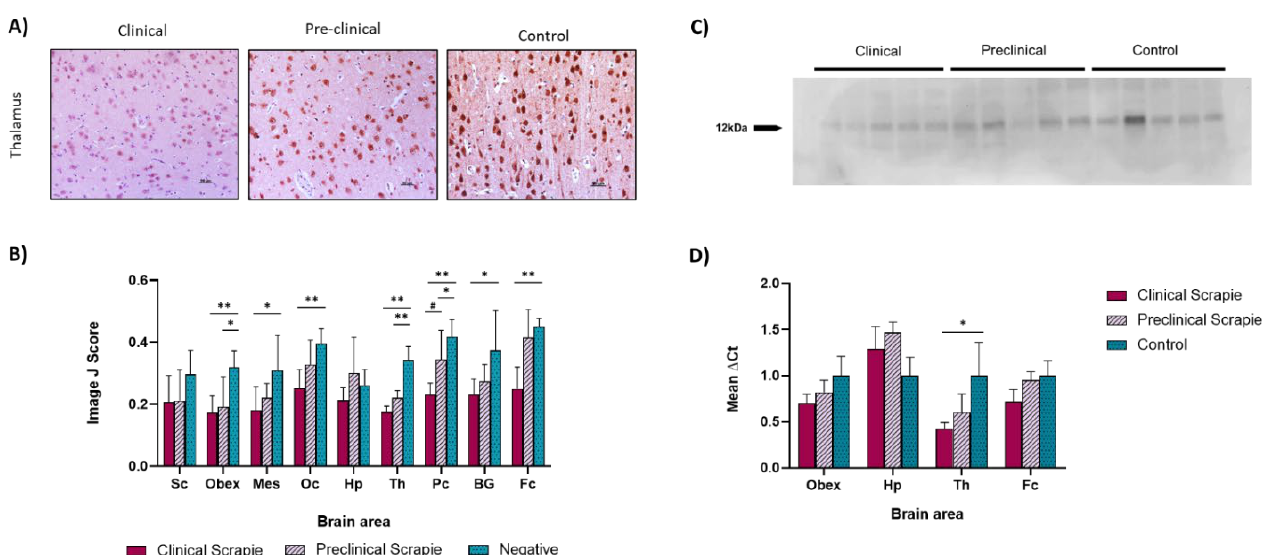
Figure 1. Assessment of Ng expression in clinical and preclinical scrapie-infected sheep and control sheep. ( A ) Representative images of Ng immunostaining in the thalamus from clinical ( n = 8), preclinical ( n = 5), and control ( n = 8) sheep, where cytoplasmic labeling is observed. ( B ) Evaluation of Ng staining in the brains of clinical, preclinical, and control animals using Image J software in the spinal cord (Sc), obex, mesencephalon (Mes), occipital cortex (Oc), hippocampus (Hp), thalamus (Th), parietal cortex (Pc), basal ganglia (BG), and frontal cortex (Fc). Control sheep showed the highest scores in most of the assessed areas (except the hippocampus), followed by preclinical animals, while clinical sheep displayed the lowest scores in all brain areas. Evaluation of differences between groups was performed using the one-way ANOVA test followed by the Bonferroni post hoc test (# p = 0.05, * p < 0.05, and ** p < 0.01). The data shown in the figure represent the mean and the standard error of the mean (mean ± SEM). A tendency toward significance was found in the parietal cortex between clinical and preclinical sheep. ( C ) Western blot analyses for Ng in the frontal cortex of different groups of sheep using the Ng36 antibody. Samples correspond to clinical, preclinical, and control sheep. The detection of a band at ~12 kDa confirms the specificity of the antibody. ( D ) mRNA expression profiles of the Ng-encoding gene in the obex, hippocampus, thalamus, and frontal cortex of clinical, preclinical, and control sheep. Relative expression levels are expressed as the mean ± standard deviation. Normalization of the results was performed using the expression of SDHA and GAPDH housekeeping genes. The expression values were determined using the 2 −∆∆Ct method, and differences between experimental groups were analyzed using the one-way ANOVA test, followed by the Bonferroni post hoc test (* p < 0.05).